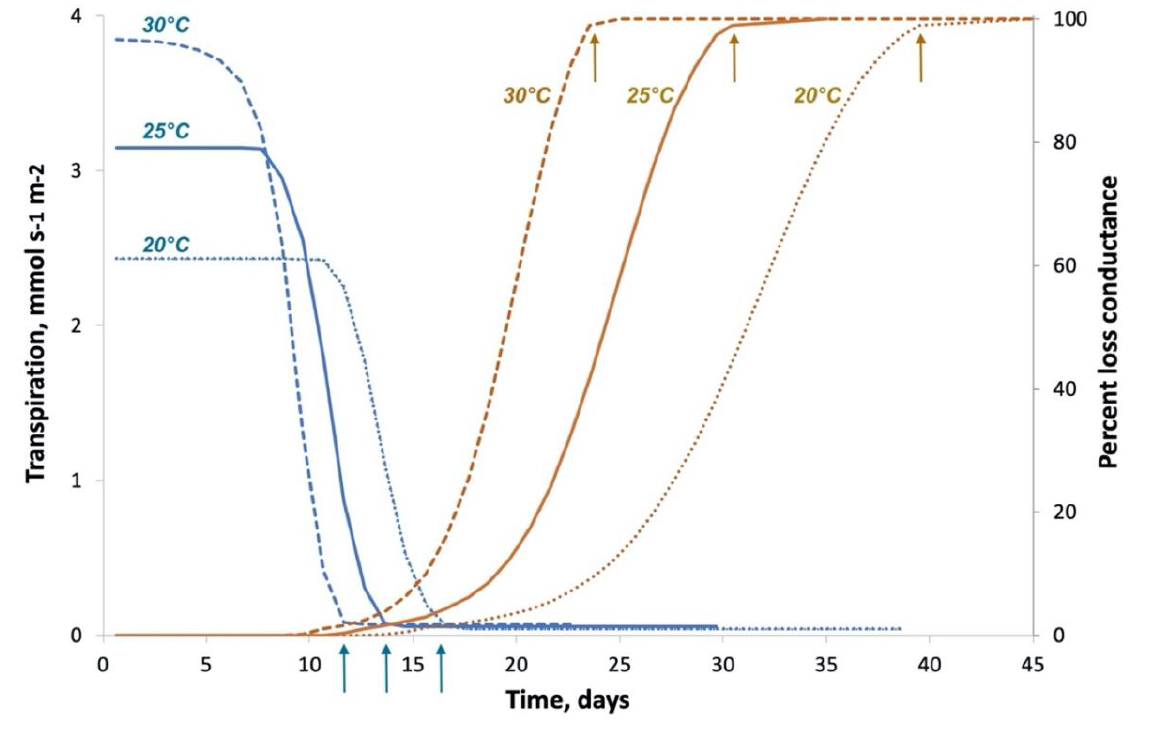
Figure 3. Typical time variations of leaf transpiration (blue) and xylem embolism (orange) for control plants exposed to a water stress at day 0 under three different air temperatures (different line types). Plants exposed to higher temperatures closed their stomata earlier (blue arrows) but displayed a shorter time to total hydraulic failure (orange